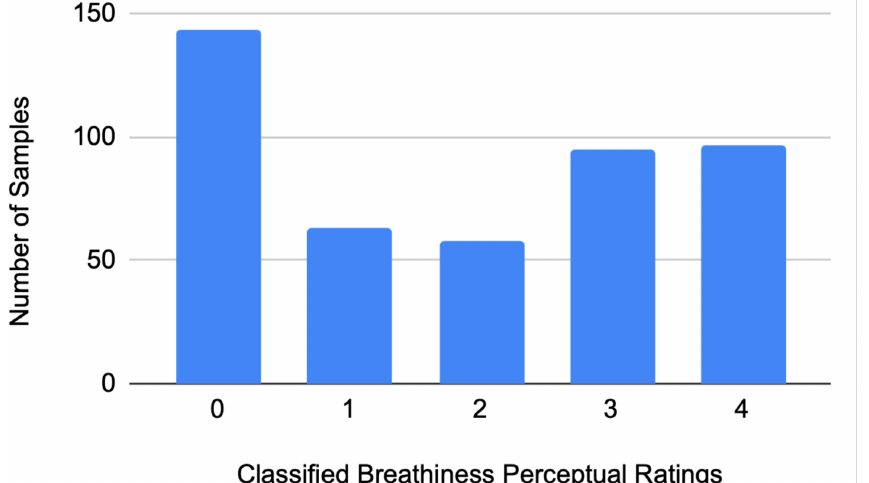
Figure 5. The numbers of samples per